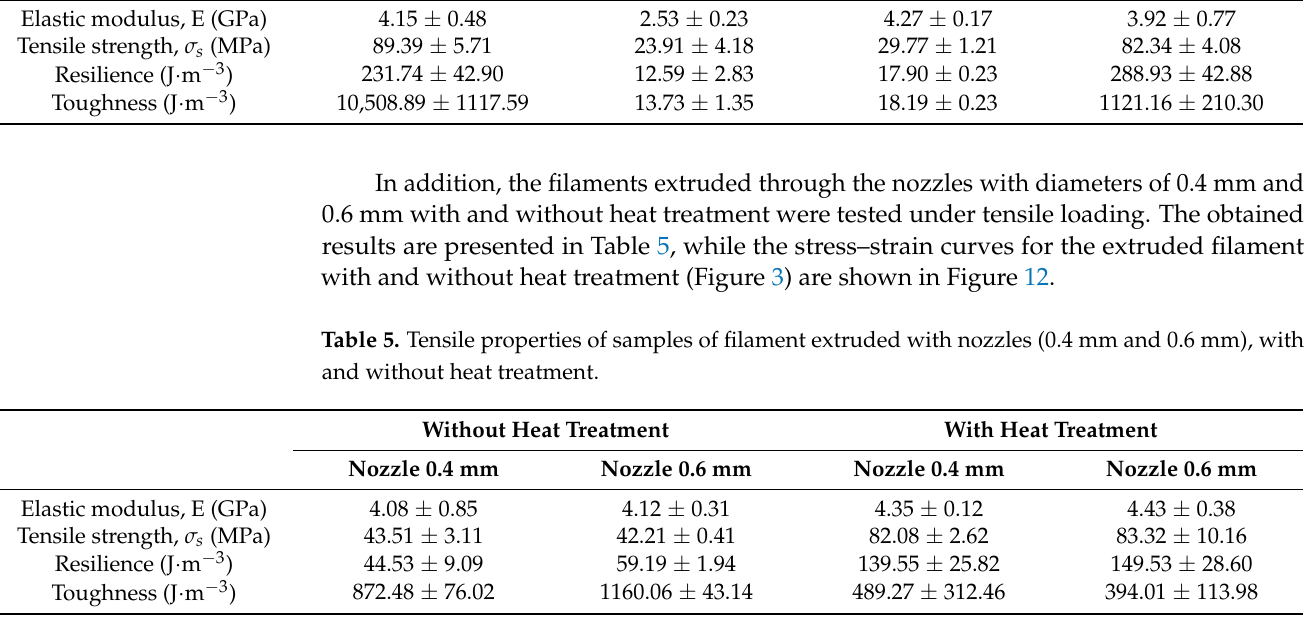
Table 4. Tensile properties of as-delivered filament samples in comparison with standard printed samples without heat treatment.